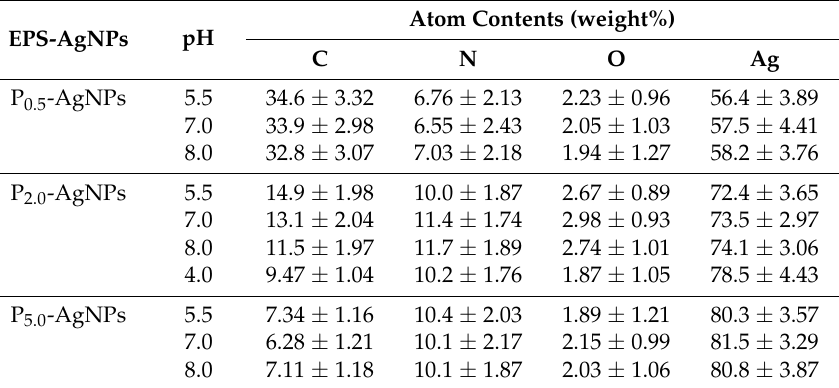
Table 2. Elemental composition of EPS-AgNPs (by energy dispersive